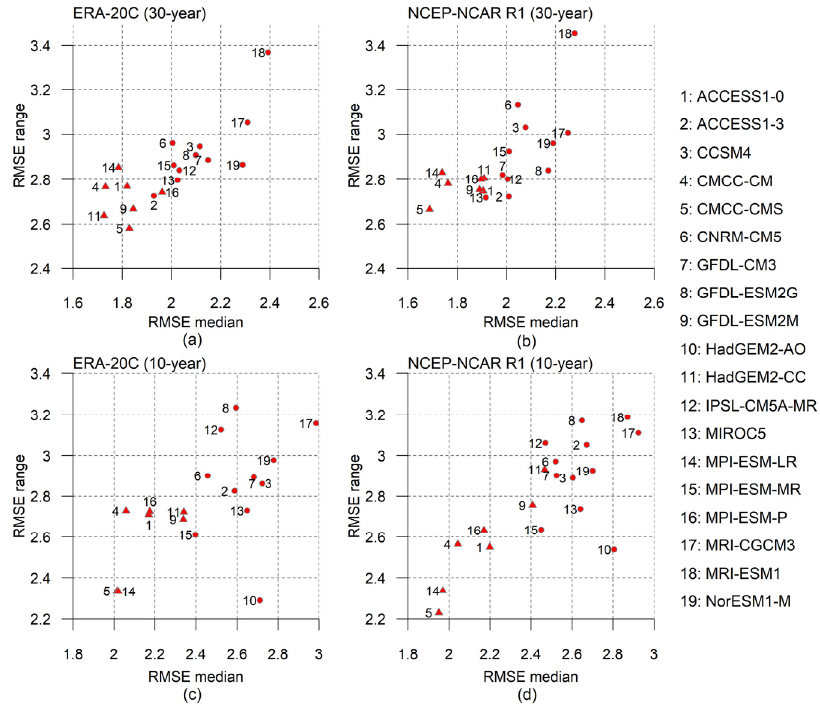
Figure 5. Characterization of GCMs in terms of their calculated RMSE medians and RMSE ranges in the case of ( a , b ) the 30-year-long periods and ( c , d ) the 10-year-long periods. The reference dataset is the ERA-20C in ( a , c ) and the NCEP-NCAR R1 in ( b , d ). GCMs with associated RMSE median below the RMSE median obtained from all GCMs in all four cases are denoted with triangles. The HadGEM2-AO and the MRI-ESM1 are considered as offscale GCMs, therefore those are omitted from ( a , b ) and from ( c ), respectively.